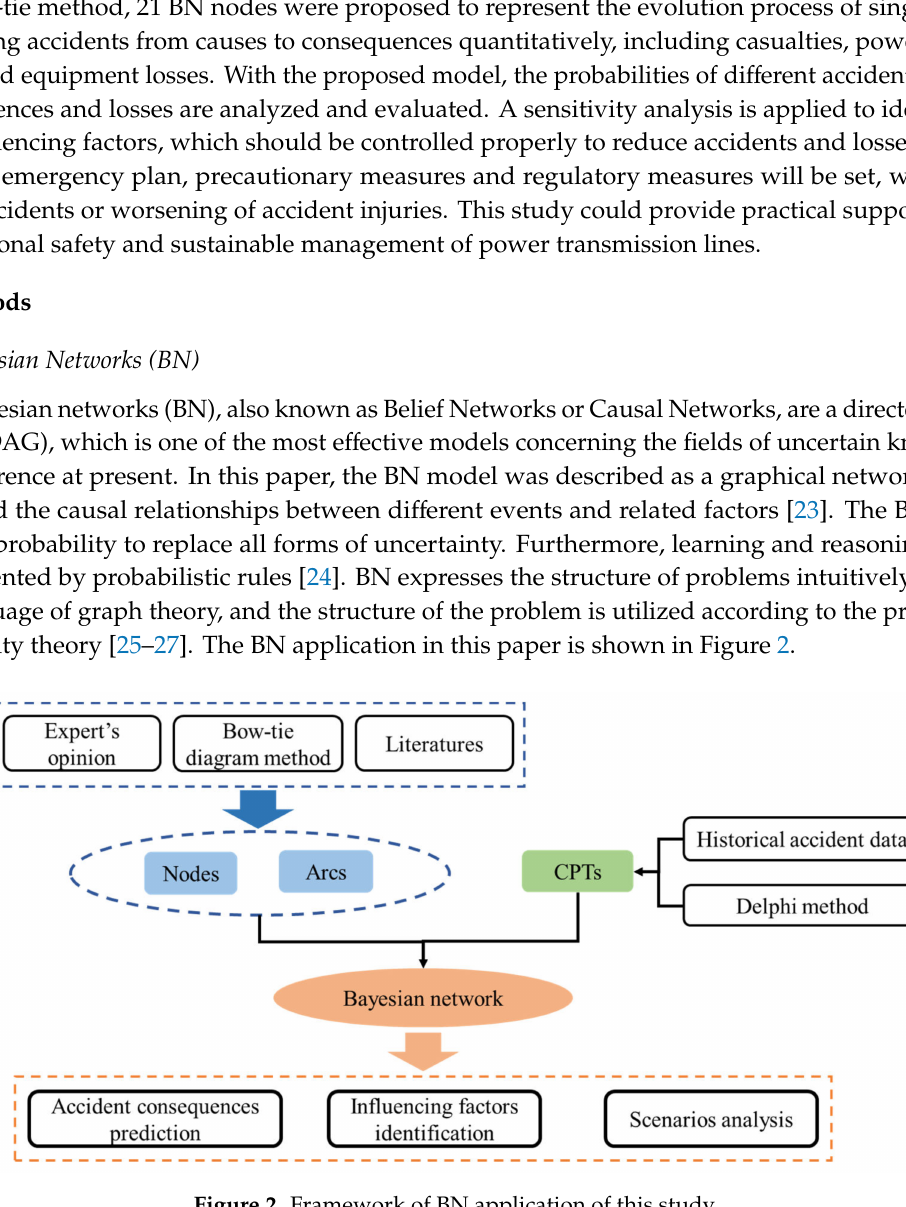
Figure 2. Framework of BN application of this